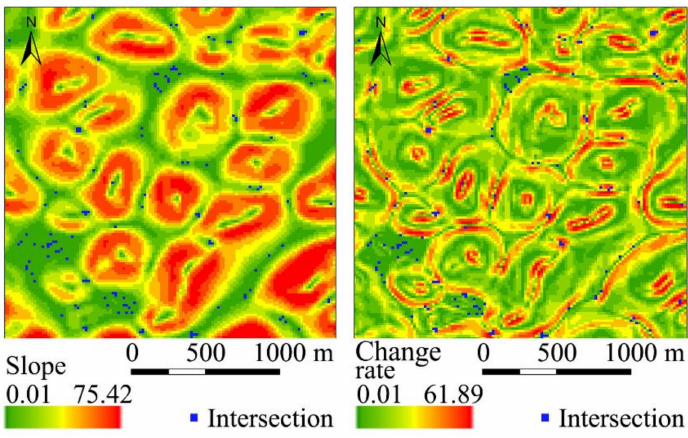
Figure 4. Location of intersection points of slope and its change rate.